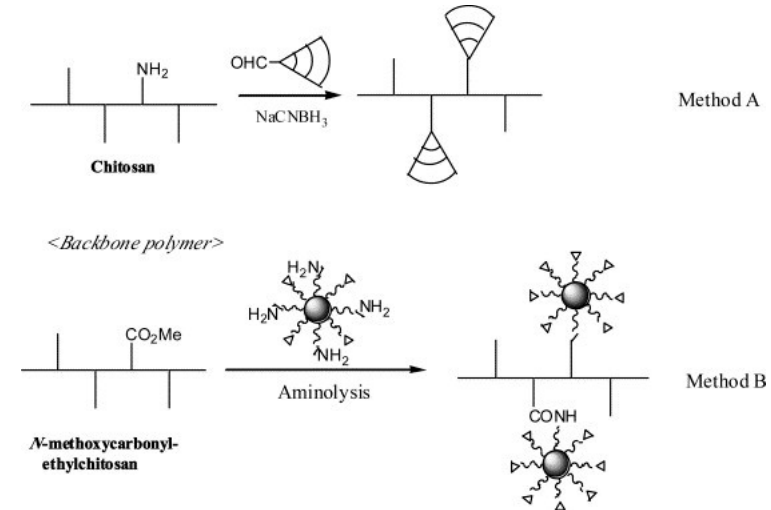
Figure 16. Synthetic strategy on chitosan–dendrimer hybrid. Reprinted from [12], Copyright 2004, with permission from Elsevier.